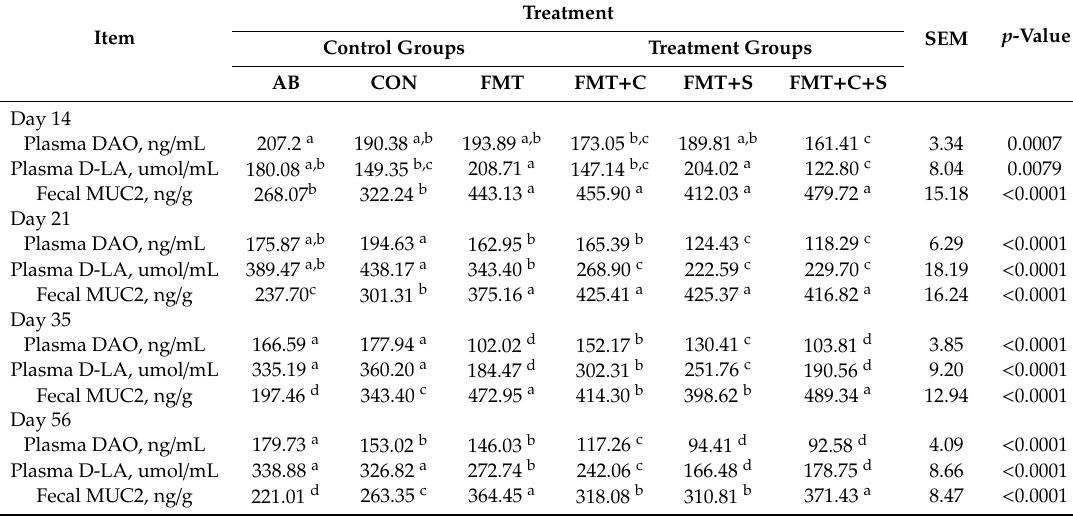
Table 3. E ff ects of early intervention on the intestinal barrier function in piglets.